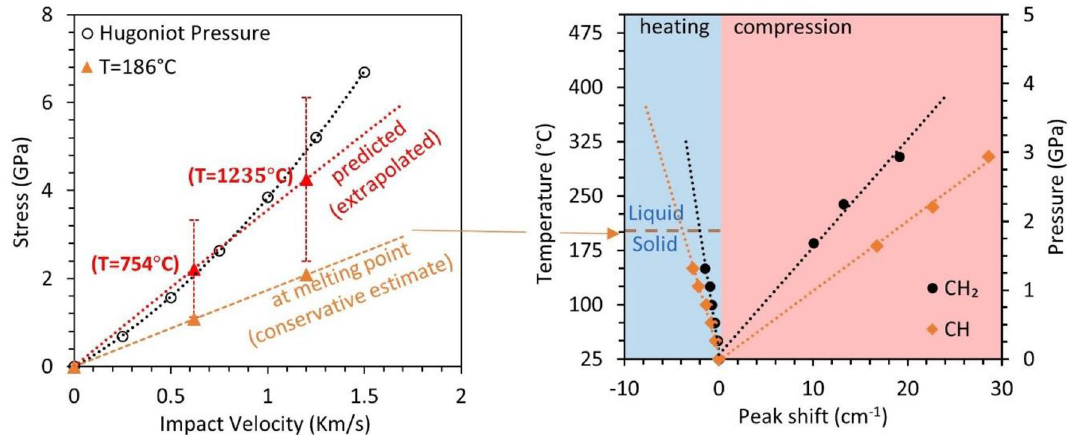
Figure 5. Estimated shock pressures during shock compression at different impact velocities by accounting for temperature effects with different limits on maximum temperature.